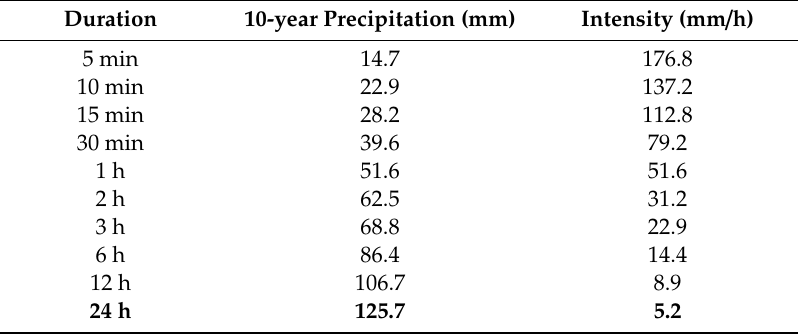
Table 3. NRCS 10-year, 24-h design storm for Philadelphia,